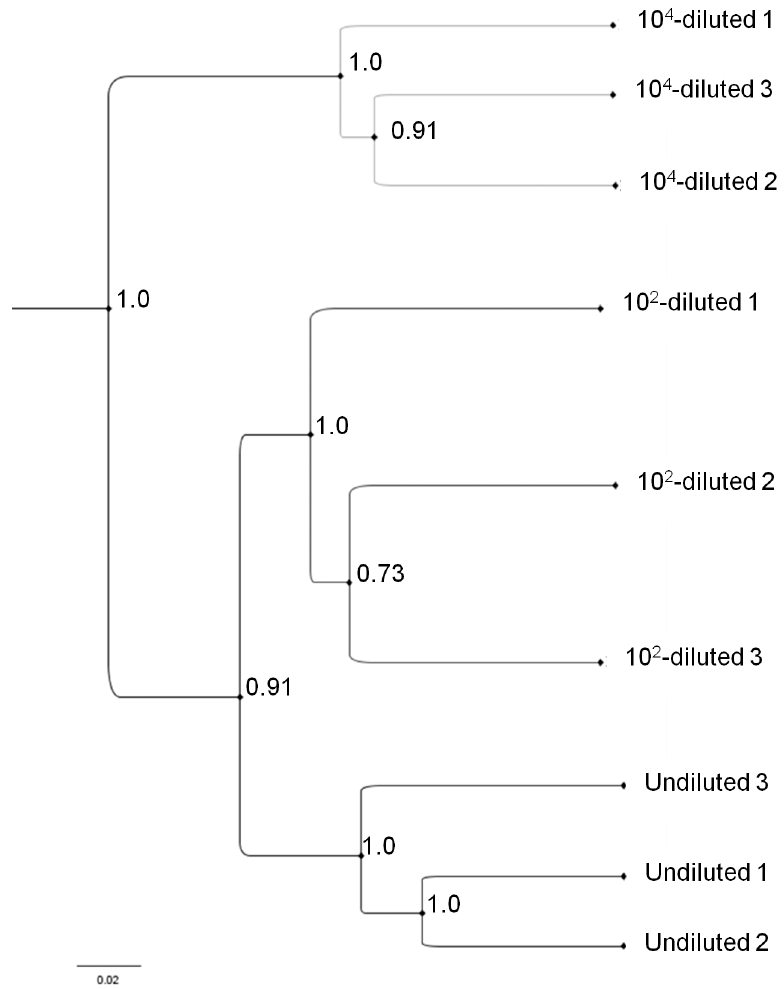
Figure 4. Jackknifed Unweighted Pair Group Method with Arithmetic mean (UPGMA) cluster tree of the constructed microcosms. UPGMA clustering was made from the 10 jackknifed weighted UniFrac distance matrix generated for each constructed microcosm.